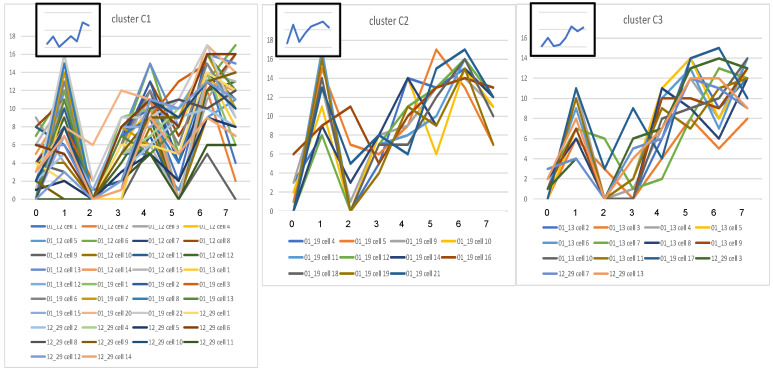
Signatures for cells in SP-A2 clusters.Line graphs from the cells composing each of the 3 main clusters (C1, C2, C3 — Figure 4C) for all AMs from SP-A2 mice are shown. Details are as described in legend for Figure 5.